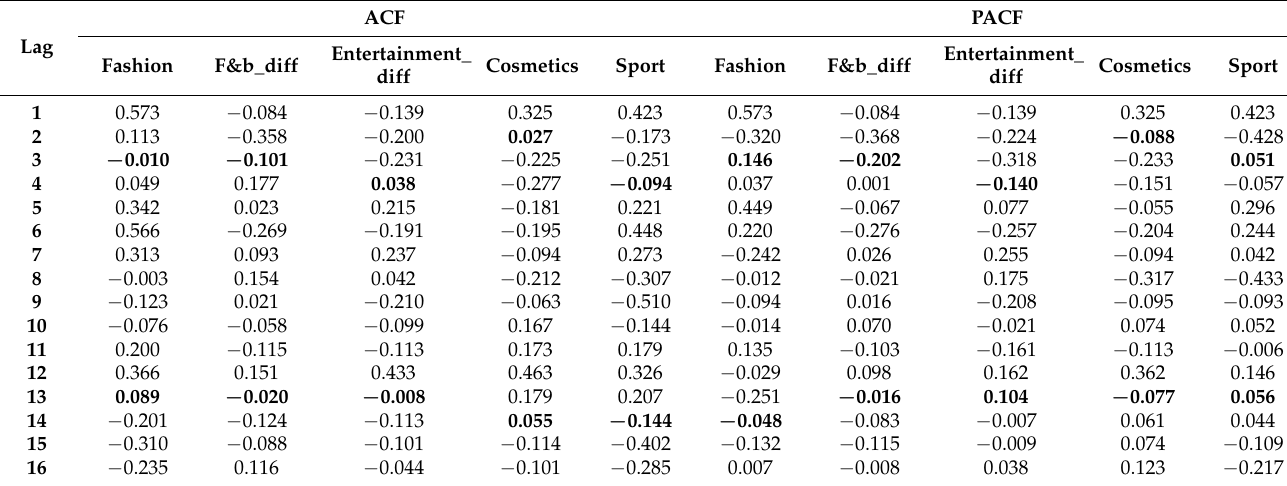
Table 3. ACF and PACF of each retail category’s sales.